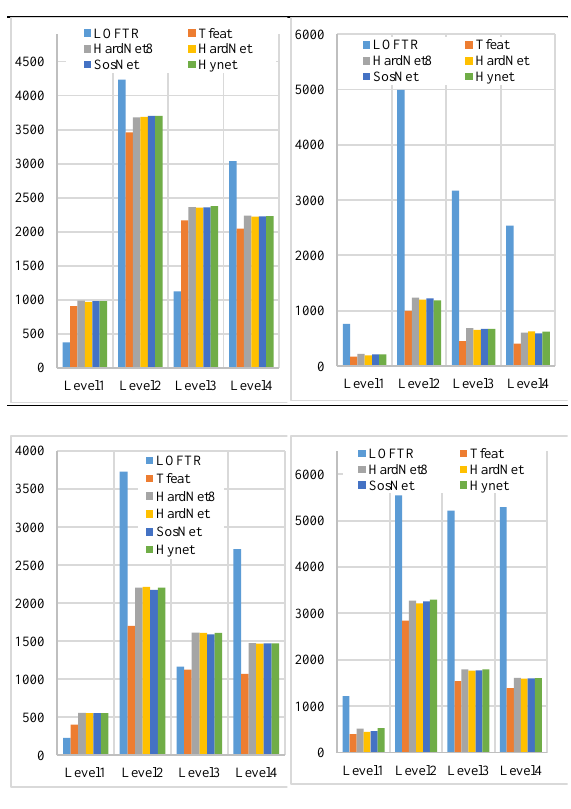
Figure 6: the number of identified inliers for the scale test. The first row from left to right relate to cases a and b, and the second row from left to right relates to cases c and d, respectively.